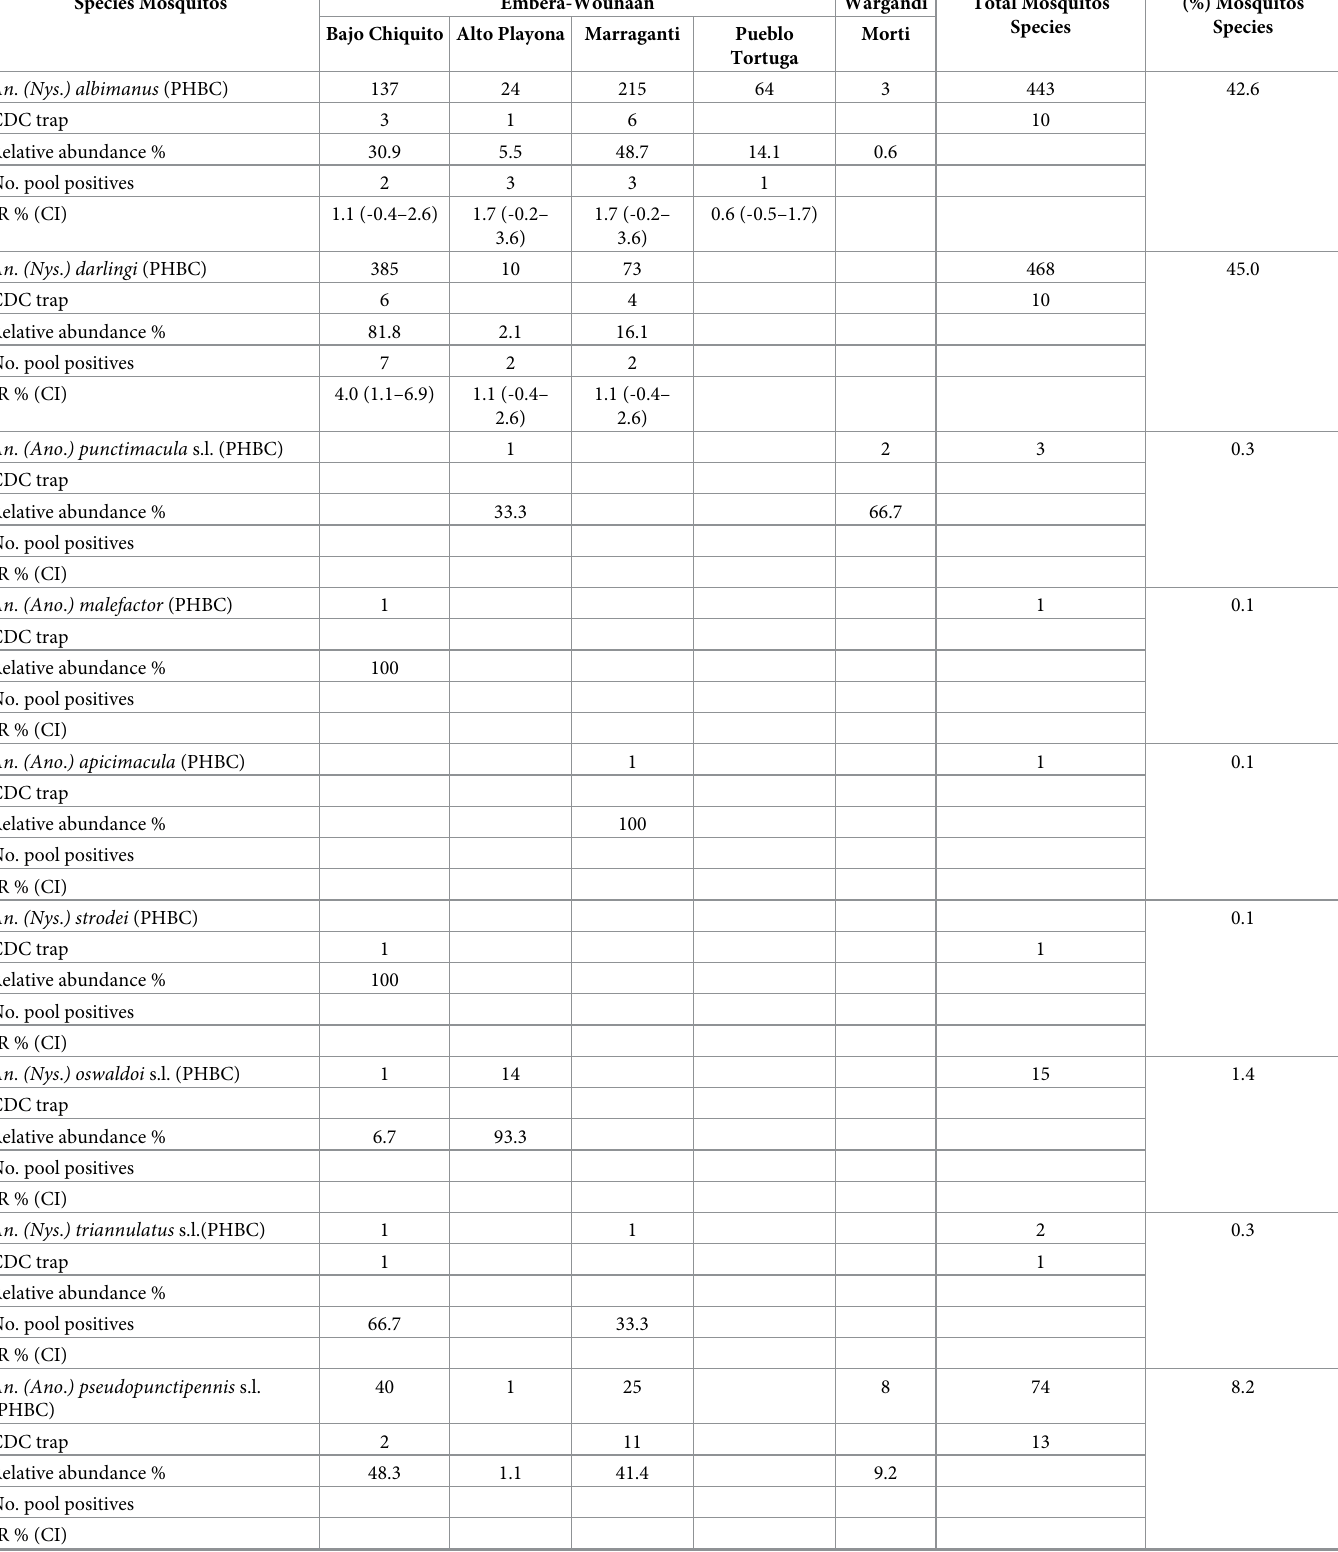
Table 2. Abundance and natural Plasmodium vivax infection in mosquitoes collected in Darie´n, Panama. Species